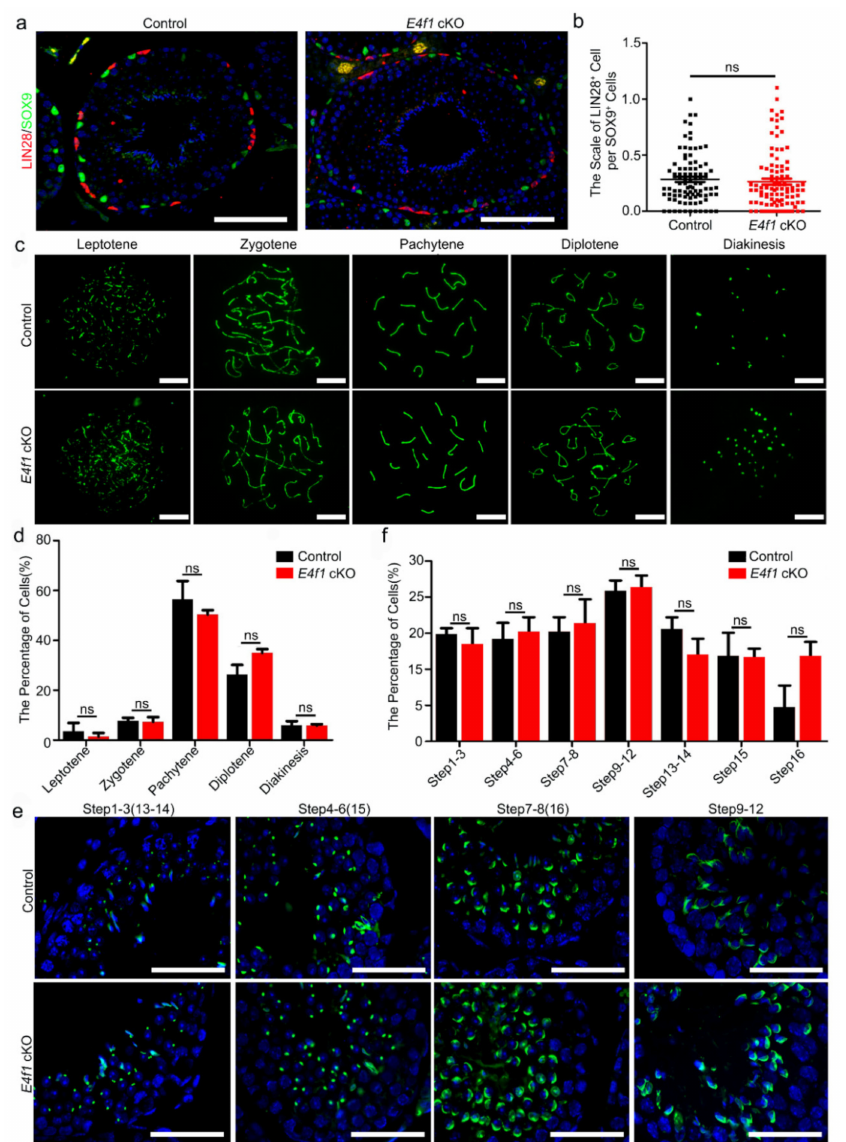
Figure 3. E4f1 deletion in Sertoli cells did not a ff ect meiosis progression and spermiogenesis ( a ) Immunofluorescent staining for SOX9 and LIN28 in cross-sections of testes from controls and E4f1 cKO male mice. Scale bar = 100 µ m. ( b ) Quantification of the number of spermatogonia per Sertoli cell in testes from controls and E4f1 cKO male mice. n = 3. ( c ) Immunofluorescent staining for SYCP3 in spread spermatocyte from controls and E4f1 cKO male mice. Scale bar = 10 µ m. ( d ) Quantification of the number of di ff erent stages spermatocyte of meiosis per mice of controls and E4f1 cKO male mice. n = 3. ( e ) Immunofluorescent staining for PNA in cross-sections of testes from controls and E4f1 cKO male mice. Scale bar = 50 µ m. ( f ) Quantification of the number of di ff erent stages spermatozoa of meiosis per mice of control and E4f1 cKO male mice. n =